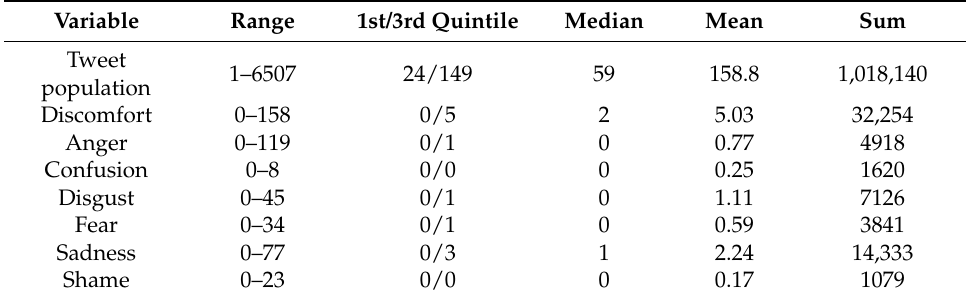
Table 1. Descriptive figures for aggregated Tweets at the census tract level over the entire study period in New York City from 10 October–18 November 2012. For example, the range of tweet population (or individual emotions) indicates the minimum and maximum number of all tweets, or of tweets with a specific emotion, found in census tracts. Note that discomfort is a combination of the negative emotions anger, confusion, disgust, fear, sadness, and shame. Tweets were coded as discomfort when they were indicative of any of these emotions at the individual level. Therefore, the numbers do not sum up at the census tract level when single emotions are compared to discomfort at that